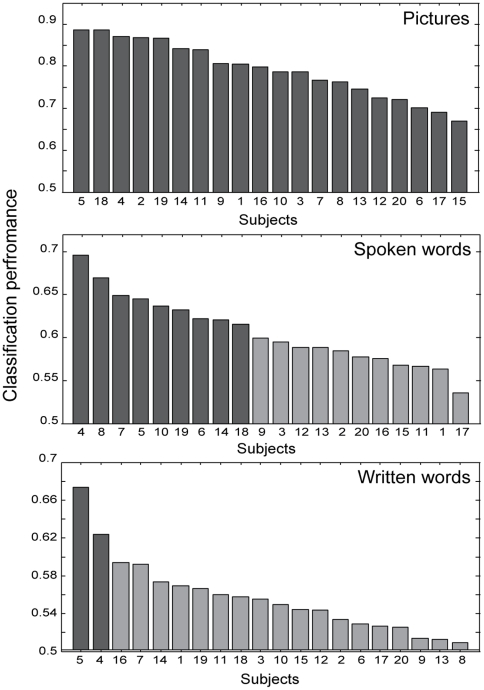
Classification performance for the three modalities.Dark bars indicate significant outcomes.